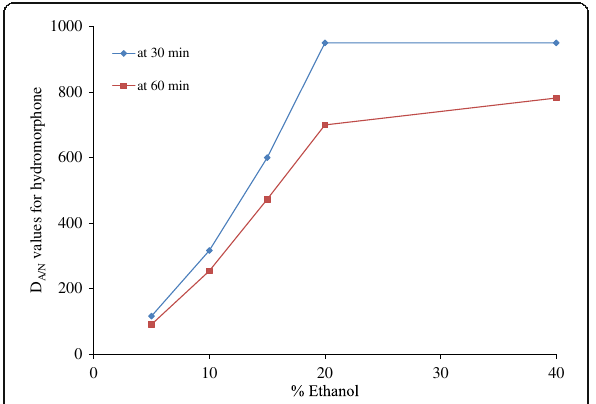
Fig. 7 D A/N value of morphine capsules in phosphate buffer/ethanol (data from reference (Walden et al. 2007))